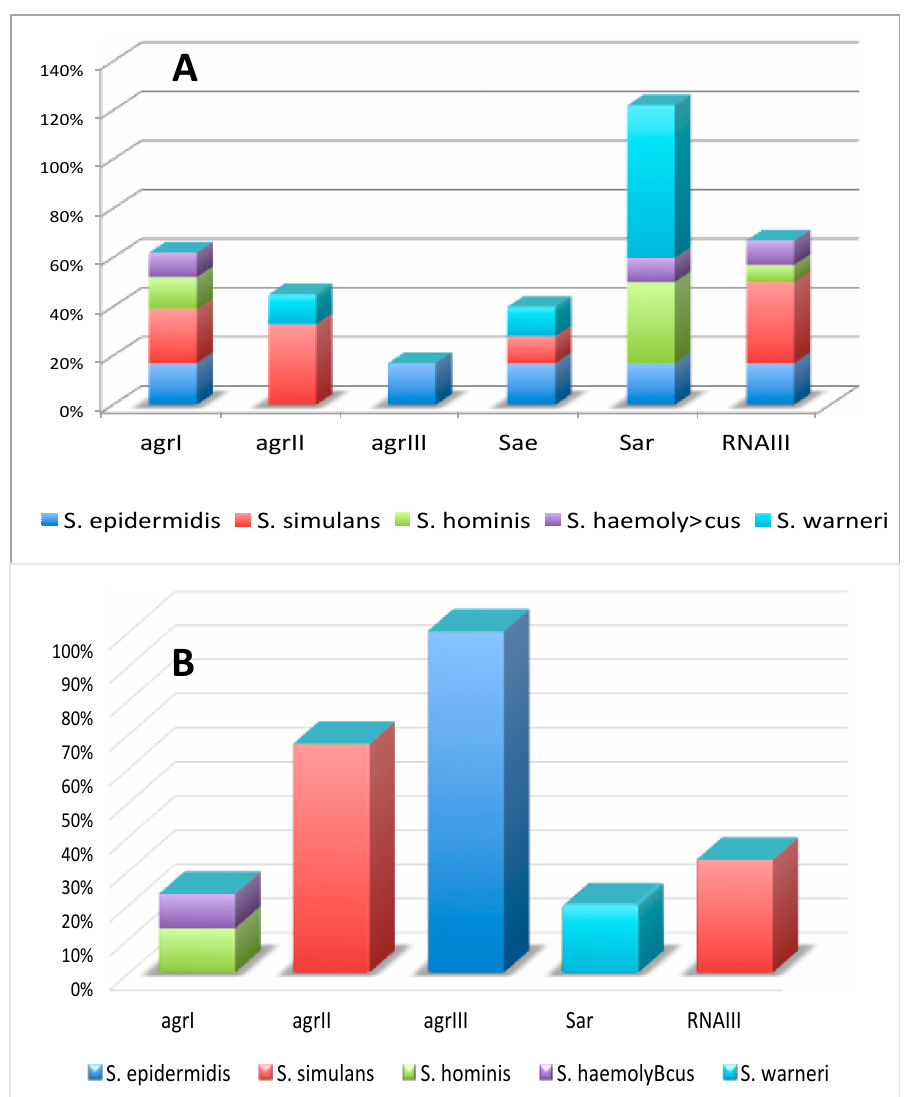
Figure 2. The presence of genes encoding regulators of virulence factors (the accessory gene regulators, ( agr ) ( A ) and their expression ( B ).